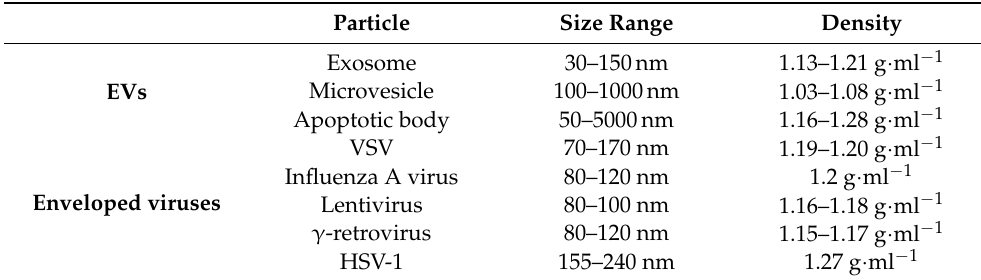
Table 2. Physical characteristics of extracellular vesicles and some enveloped viruses. VSV: vesicular stomatitis virus, HSV-1: oncolytic herpes simplex